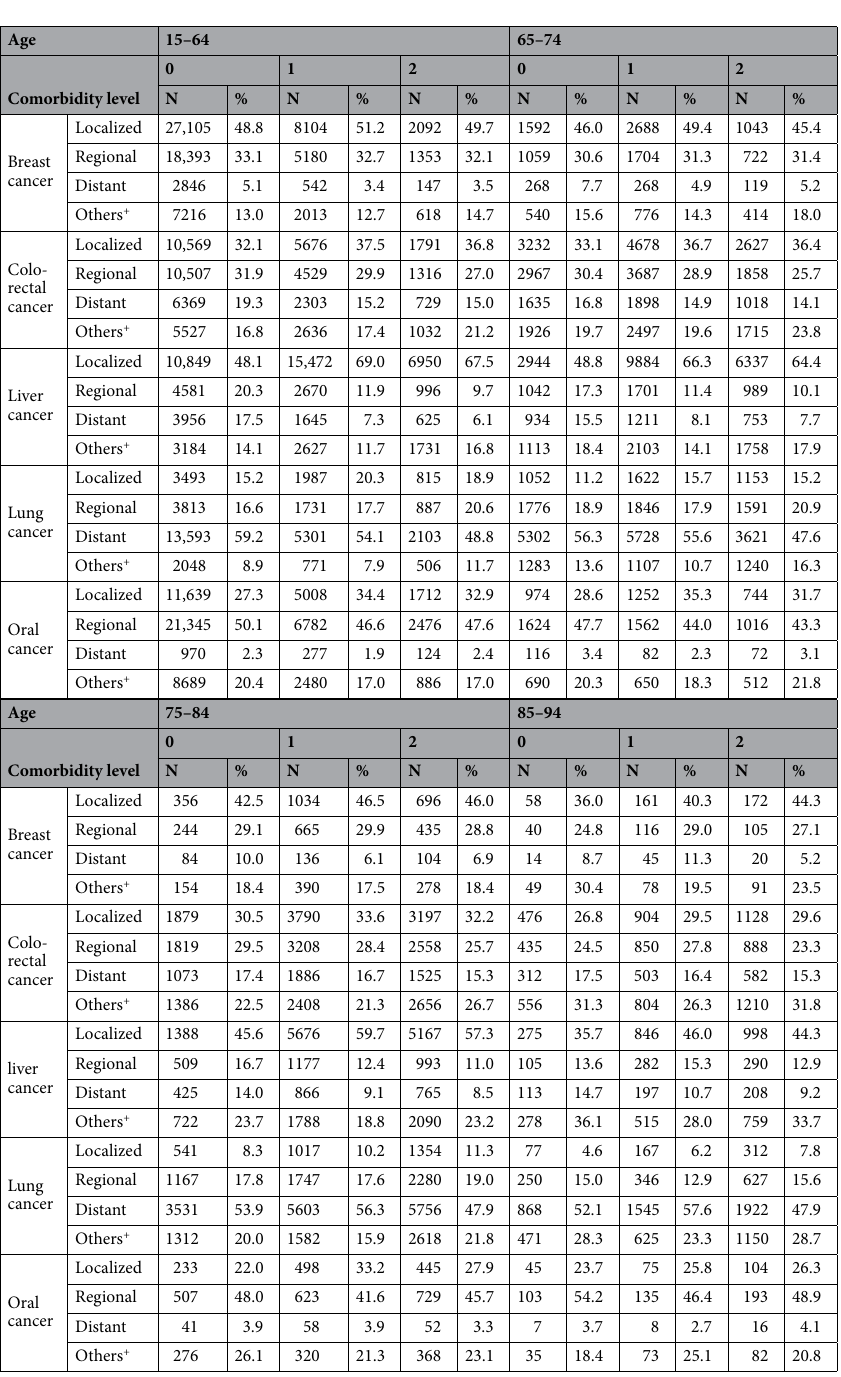
Table 3. Number and percentage of cancer patients by age, stage, and comorbidity level for each of the five cancers. + TCR cancer patients with no stage information; see Table S9 for